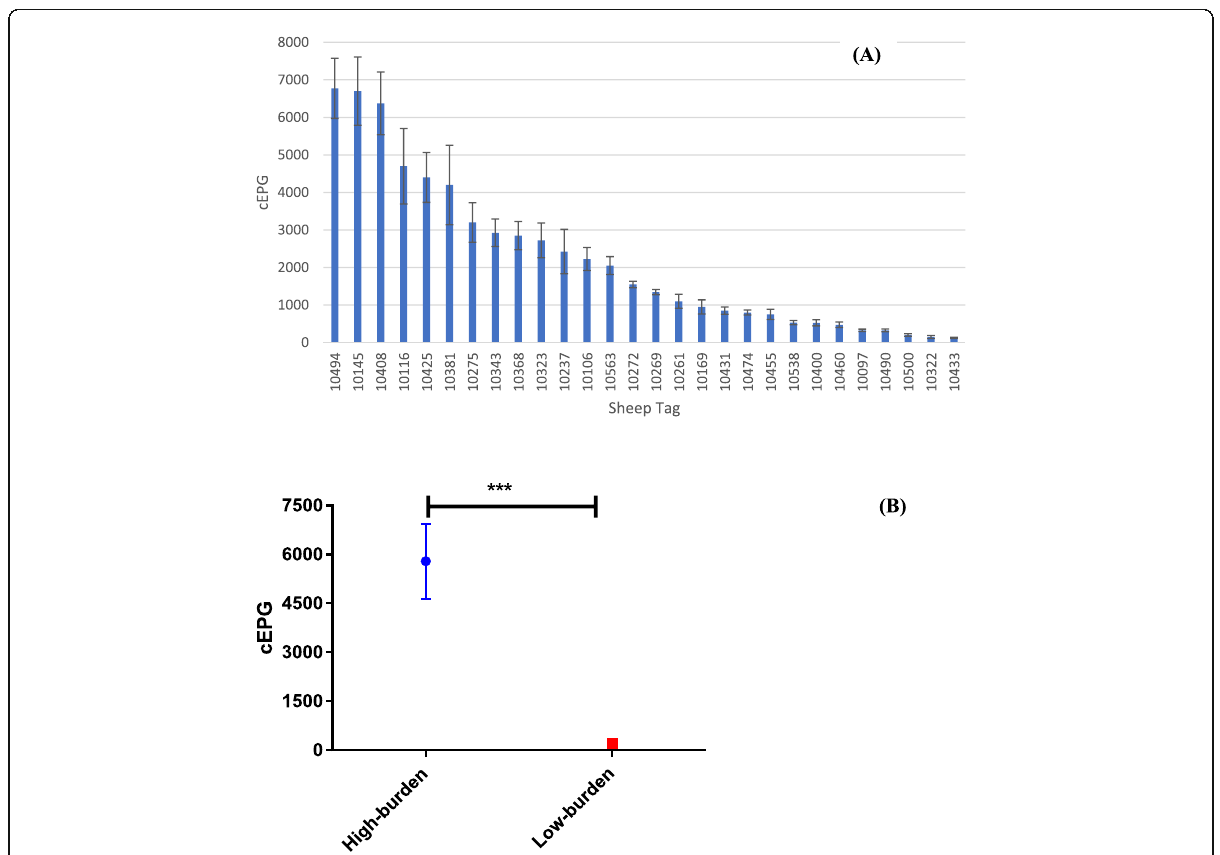
Fig. 1 Distribution of egg count data. ( a) cEPG for each of the 28 sheep. ( b ) Comparison of cEPG of high ( n = 5) and low ( n = 5) parasite burden sheep. Unpaired t-test. Error bars represent SD. *** p ≤